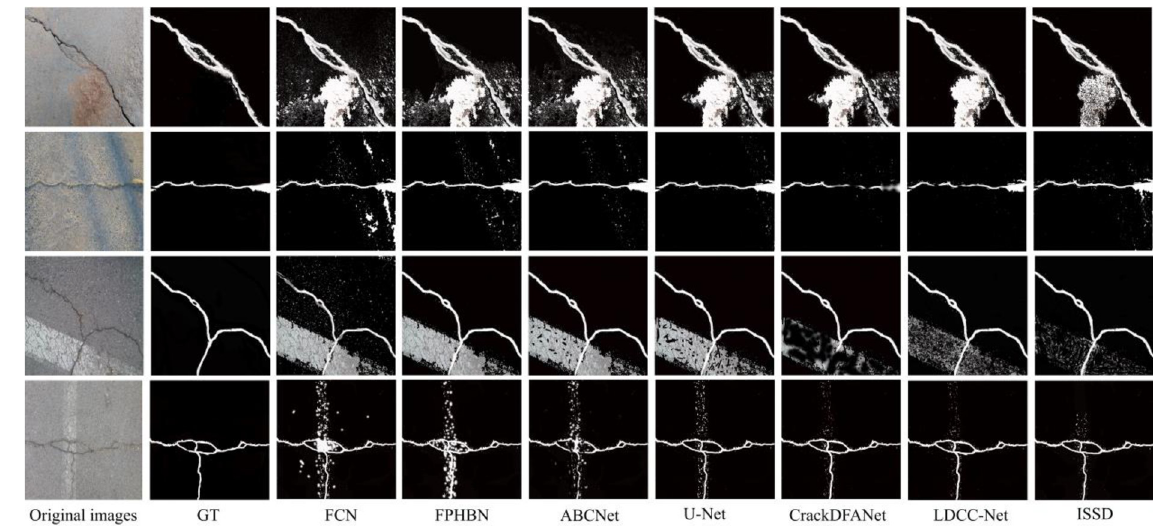
Fig 11. The visualization of detection results of compared networks in real